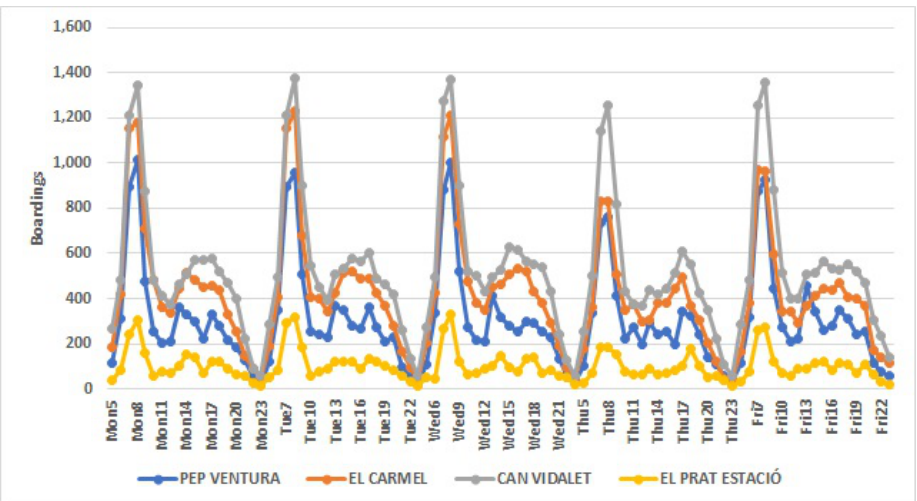
Figure 15. Pattern of boarding in stations of Cluster 3